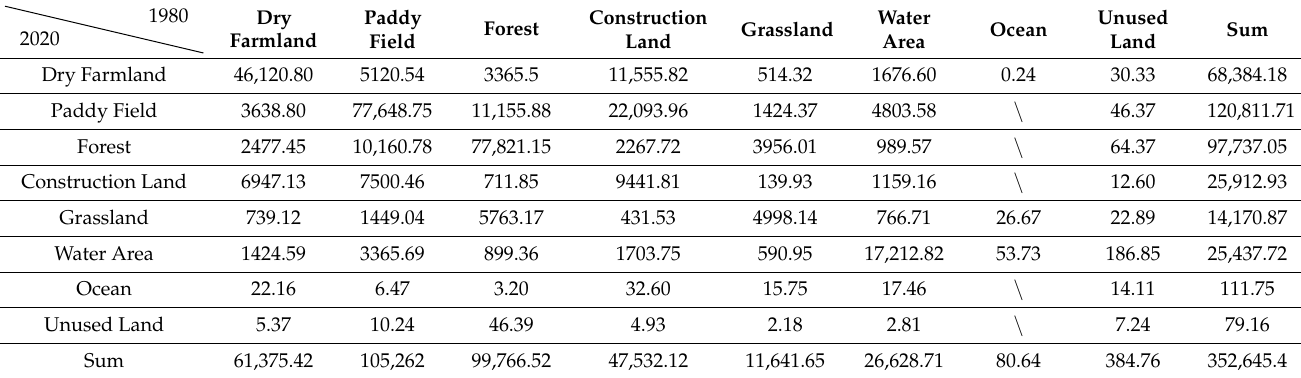
Figure 5. Conversion of cultivated land to other land use types in the Yangtze River Delta from 1980 to 2020. ( a ) Conversion rate of cultivated land to other land use types; ( b ) conversion of cultivated land to forest. For the instructions of copyright for the base map, see Figure 1. Table 3. The conversion from cultivated land to other land use types in the Yangtze River Delta from 1980 to 2020. Numbers in the table are areas of the subtypes of land use (km 2